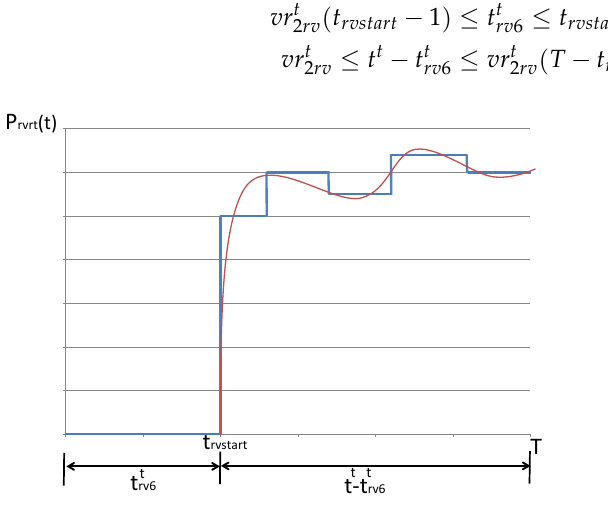
Figure 6. NCRES generation capacity